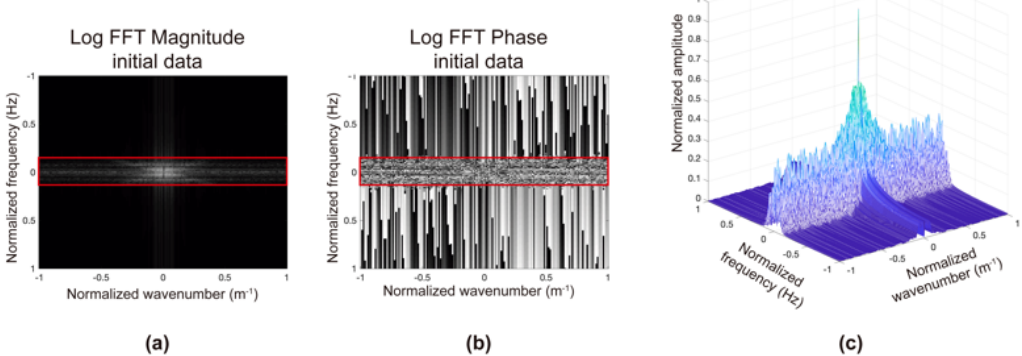
Figure 3. ( a ) Magnitude and ( b ) phase spectra of the acquired B-scan. ( c ) 3D magnitude spectrum of the same B-scan. The area inside the red lines indicates the location of useful signal in the spectra. In the 3D view, an outlier value is observed in the center of the spectrum, which corresponds to the k values near zero.